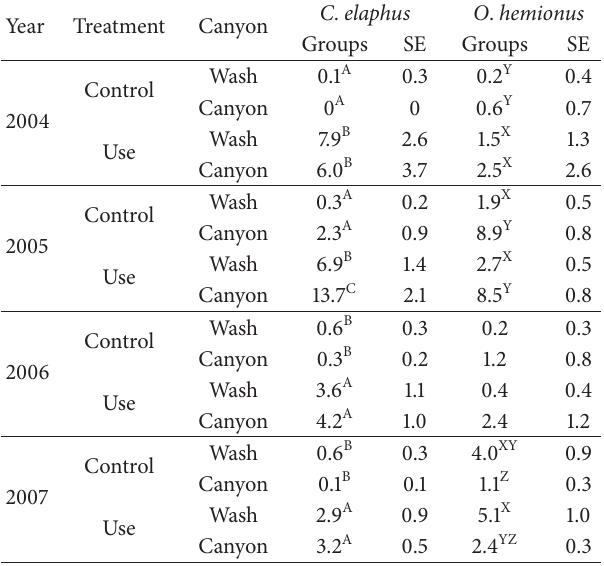
Table 1: Mean numbers of C . elaphus and O . hemionus pellet groups in use and control areas of Chaco Wash (Wash) and side canyons